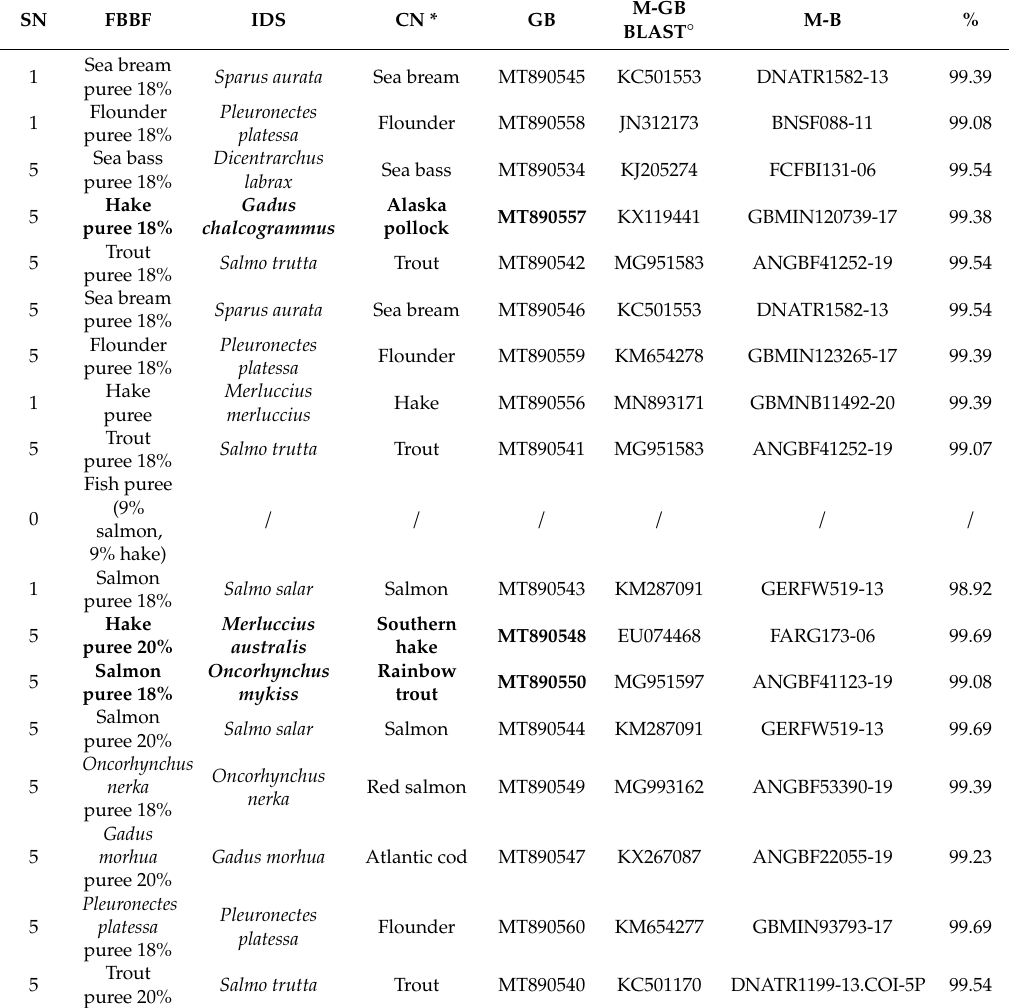
Table 1. Samples of puree baby food processed for fish species identification. SN: number of replicated samples for each baby food product; FBBF: Fish based baby food; IDS: Identified species by DNA barcoding; CN: Common name of fish species; GB: GenBank Accession N ◦ of obtained sequences; M-GB BLAST: Matched GenBank Accession from BLAST; M-B: Matched BOLD ID; %: percentage identity with 100% coverage. In bold the mislabeled products due to species substitution. The C01, C02 and C03 products declared on the label the scientific name of the species. The symbol / indicates no data due to unsuccessful DNA extraction.